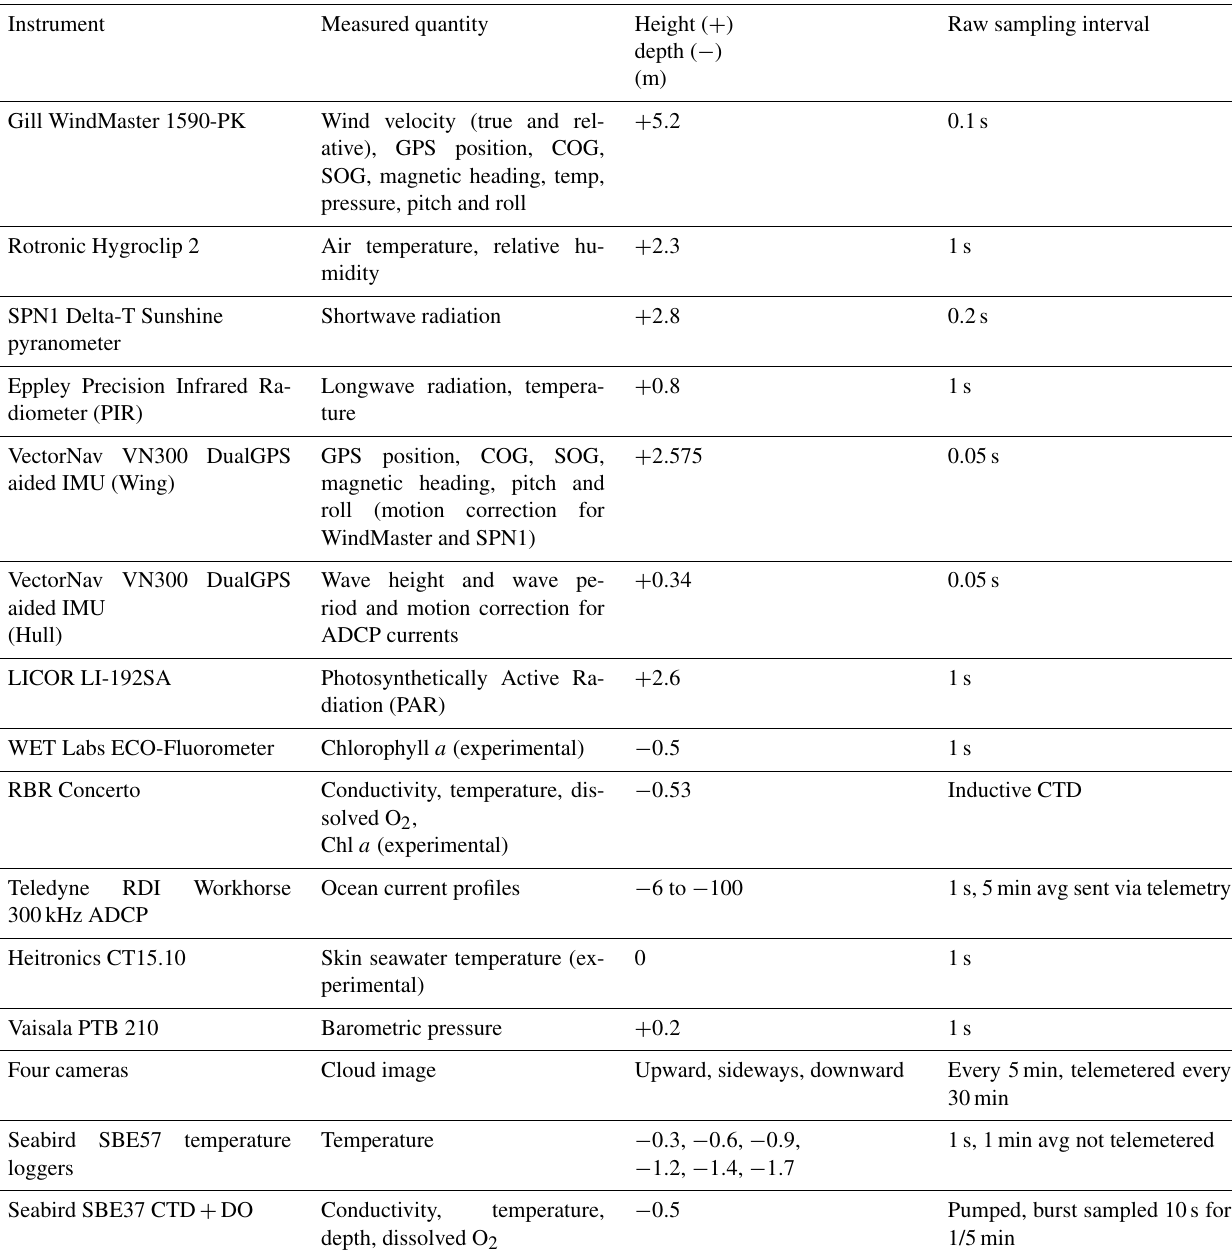
Table 10. Instrumentation on board the NOAA-sponsored Saildrones; 1min averages (5min average for ADCP current) were telemetered in real time except where noted below. Final data products are 1min averages of high-resolution raw